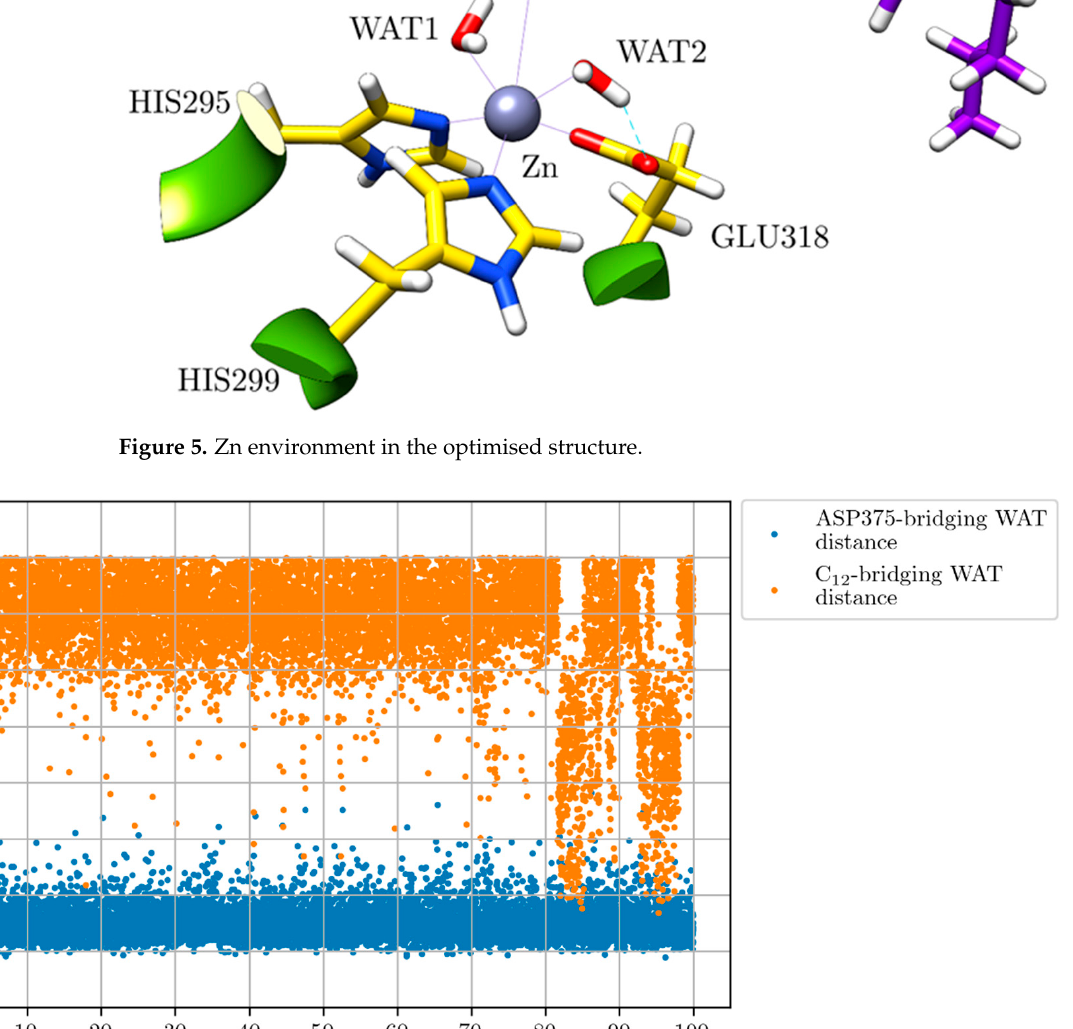
Figure 7. Distances epoxide-WAT1 (blue line), epoxide-TYR383 (orange line) and epoxide-Zn (green line) along the Molecular Dynamics simulation for the LTA 4 :LTA 4 H Michaelis complex. Finally, we can see in Figure 8 that the C 6 -C 7 bond of LTA 4 (the single bond next to the epoxide) keeps a rather pro- cis configuration along the Molecular Dynamics simula- tion. A total of 91% of the snapshots correspond to a pro- cis configuration |𝑑𝑖ℎ𝑒𝑑𝑟𝑎𝑙 𝑎𝑛𝑔𝑙𝑒 𝐻6 (cid:3398) 𝐶6 (cid:3398) 𝐶7 (cid:3398) 𝐻7| (cid:3409) 90° , whereas only 9% are associated with a pro- trans configuration |𝑑𝑖ℎ𝑒𝑑𝑟𝑎𝑙 𝑎𝑛𝑔𝑙𝑒 𝐻6 (cid:3398) 𝐶6 (cid:3398) 𝐶7 (cid:3398) 𝐻7| (cid:3410) 90° . The evolution of this di- hedral angle along the complete enzyme reaction is a key point for the formation of LTB 4 , as will be explained below.